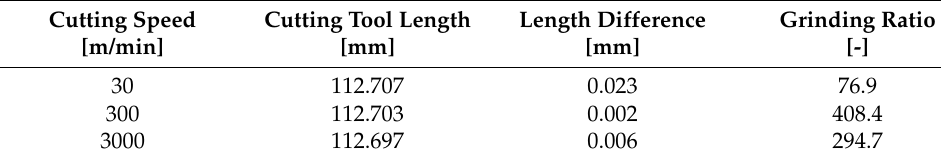
Table 5. Recorded values of tool length after machining of zirconia.